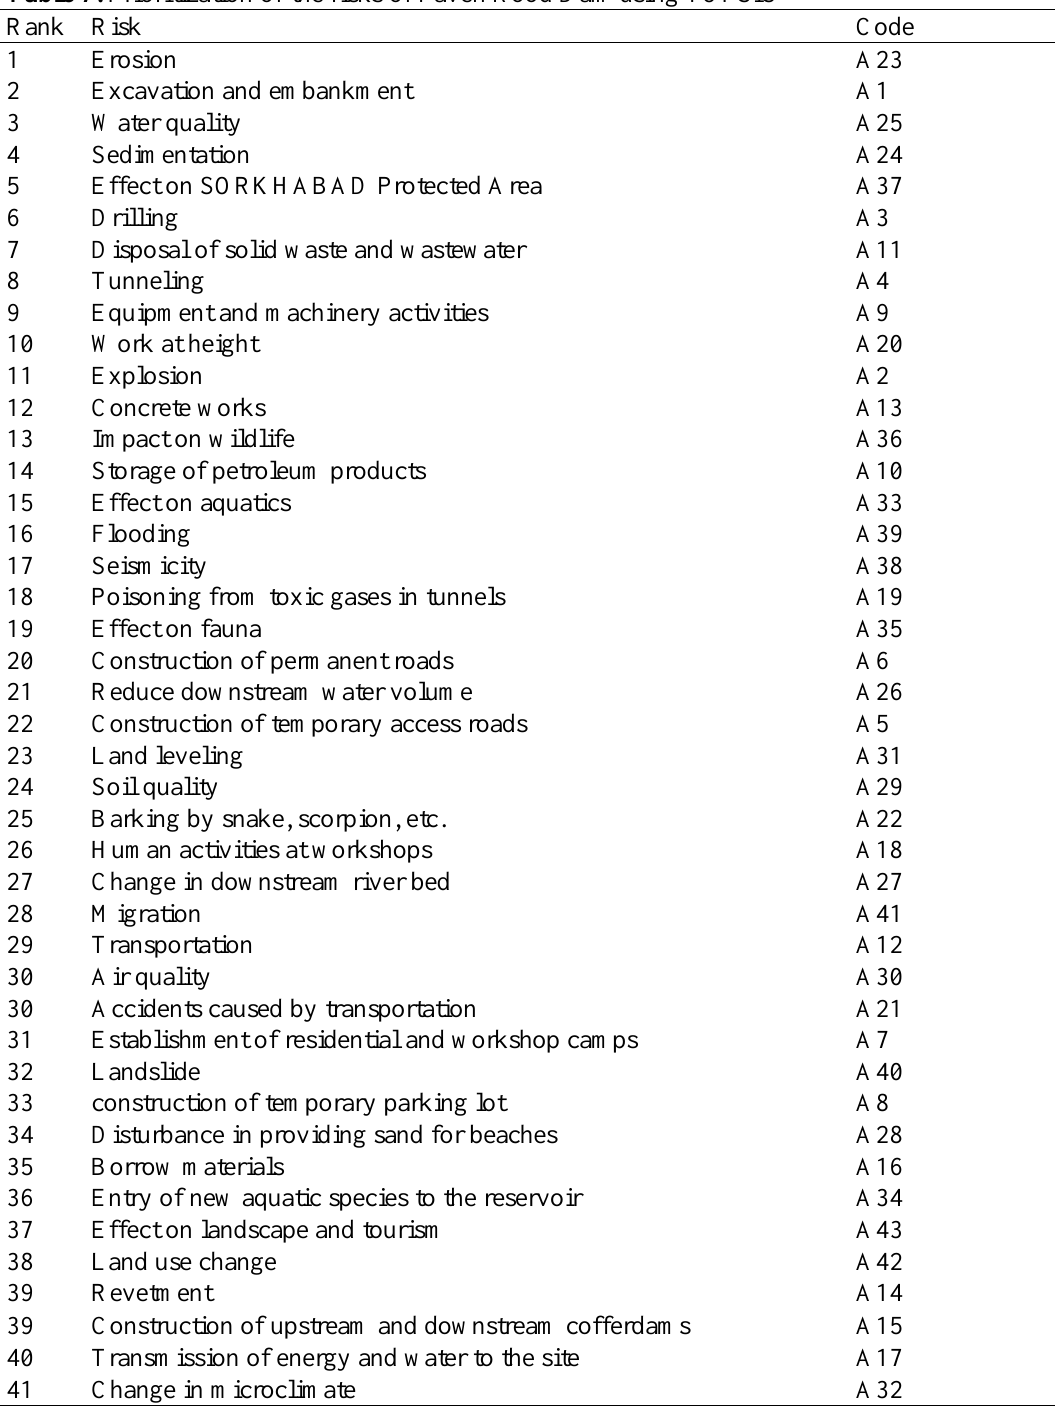
Table 7. Prioritization of the risks of Paveh Rood Dam using TOPSIS Rank